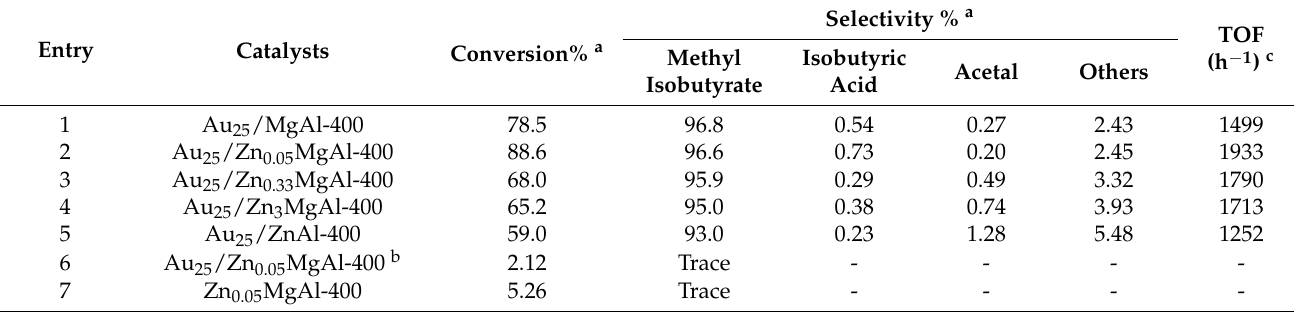
Table 3. Catalytic performances of Zn-Mg-Al mixed oxides-supported gold catalysts for synthesis of methyl isobutyrate from isobutyraldehyde and methanol.